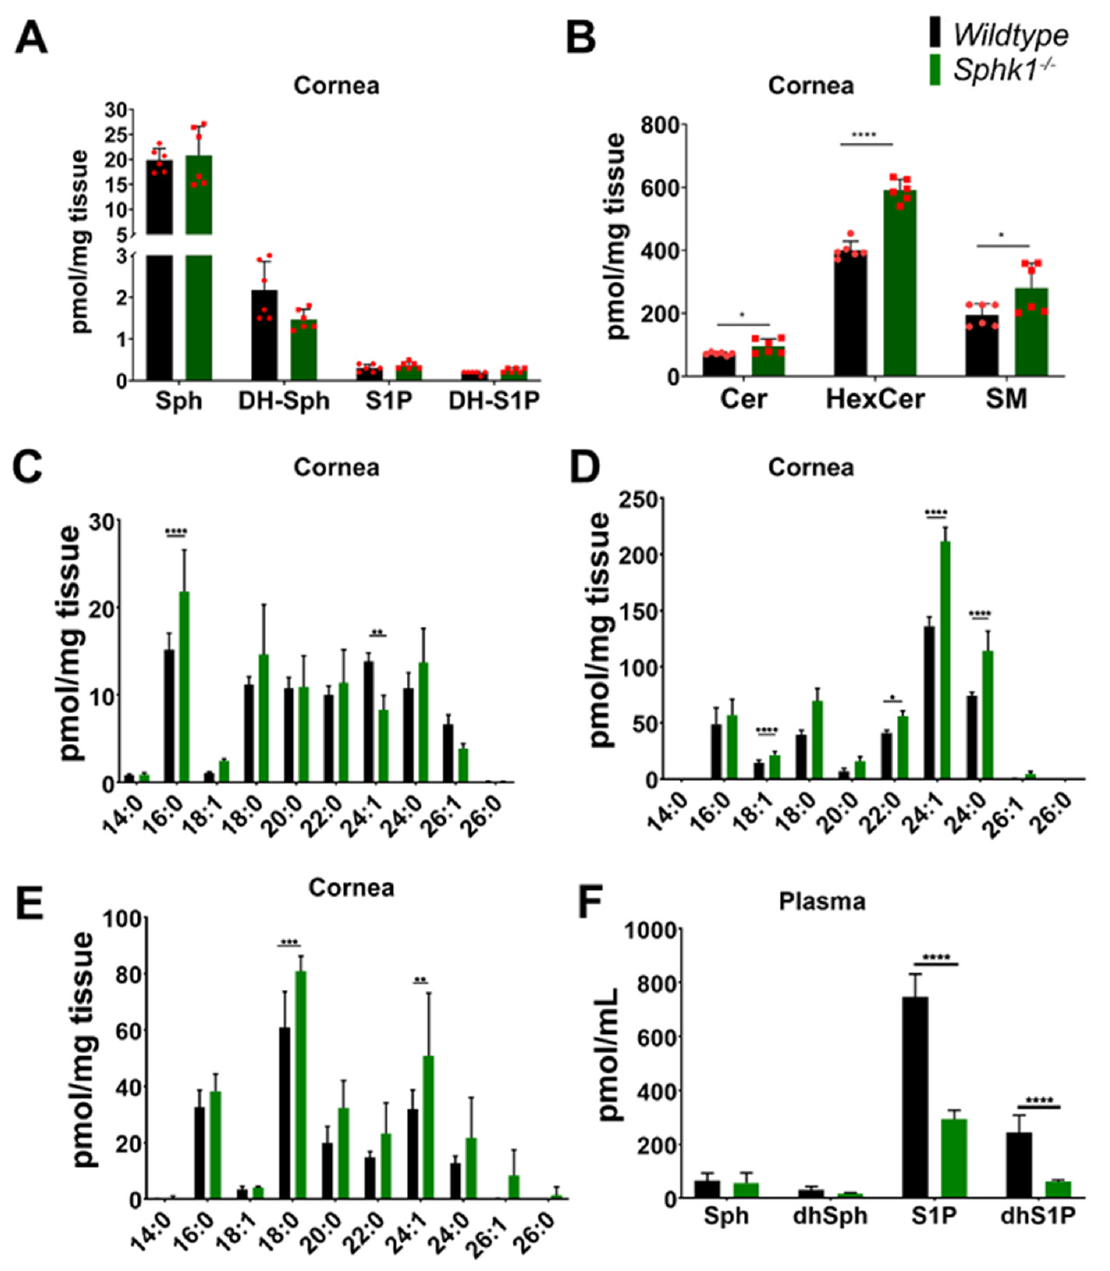
Figure 1. Ablation of Sphk1 alters sphingolipid homeostasis in the cornea and plasma. Analysis of sphingolipids from WT and Sphk1 − / − mice corneas ( n = 6) showing total sphingolipid levels ( A , B ) with individual species of ( C ) ceramide, ( D ) HexCer, and ( E ) sphingomyelin. Total sphingolipid levels in WT and Sphk1 − / − mice plasma are depicted in ( F ). (Values are mean ± SD, * p ≤ 0.05, ** p ≤